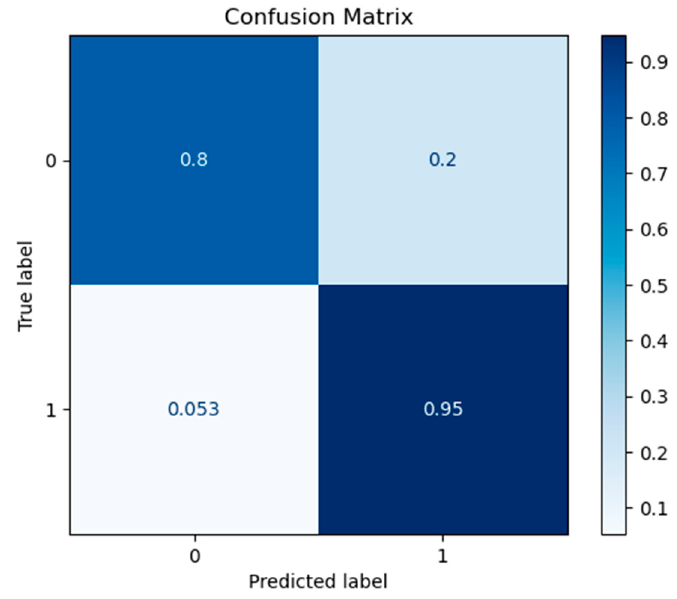
Figure 3. Confusion matrix for RF model at eight features.